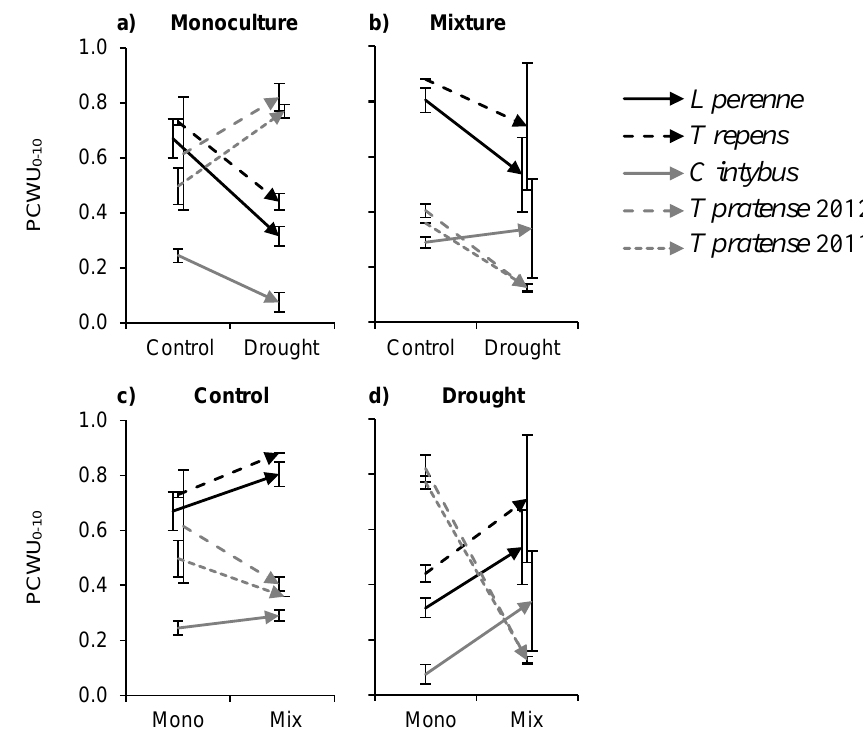
Figure 4. The shift in proportional contribution to plant water uptake from the 0–10cm soil depth interval (PCWU 0 − 10 ) of shallow-rooting species ( L. perenne and T. repens ) and deep-rooting species ( C. intybus and T. pratense 2011, 2012) as a result of water supply ( a, b : control and drought) and diversity ( c, d , monoculture and mixture). These graphs are based on the mean values presented in Fig. 2f–j, error bars represent one SE, n = 2 (for exceptions see Fig. 2).